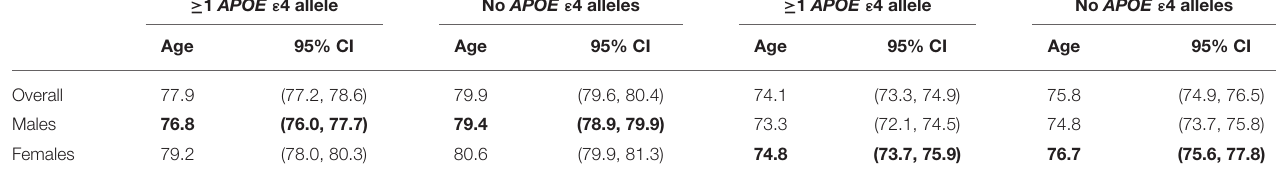
In comparison, the median age of death for White APOE ε 4 carriers was 77.9 years (95% CI: 77.2, 78.6) compared with 79.9 years (95% CI: 79.6, 80.4) for White non-carriers. White females on average had a median age of death of 79.2 years (95% CI: 78.0, 80.3) for APOE ε 4 carriers compared with 80.6 years (95%